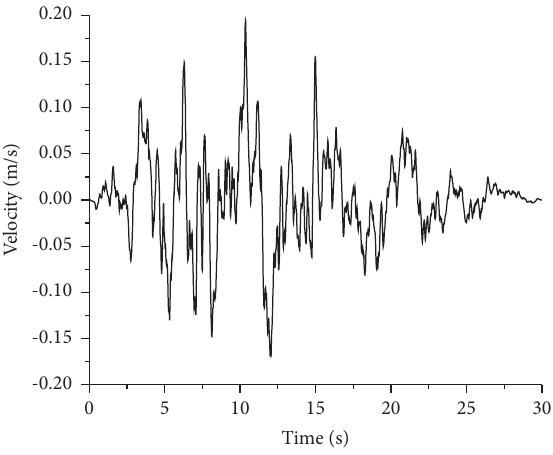
Figure 4: Tangential velocity time-history curve.